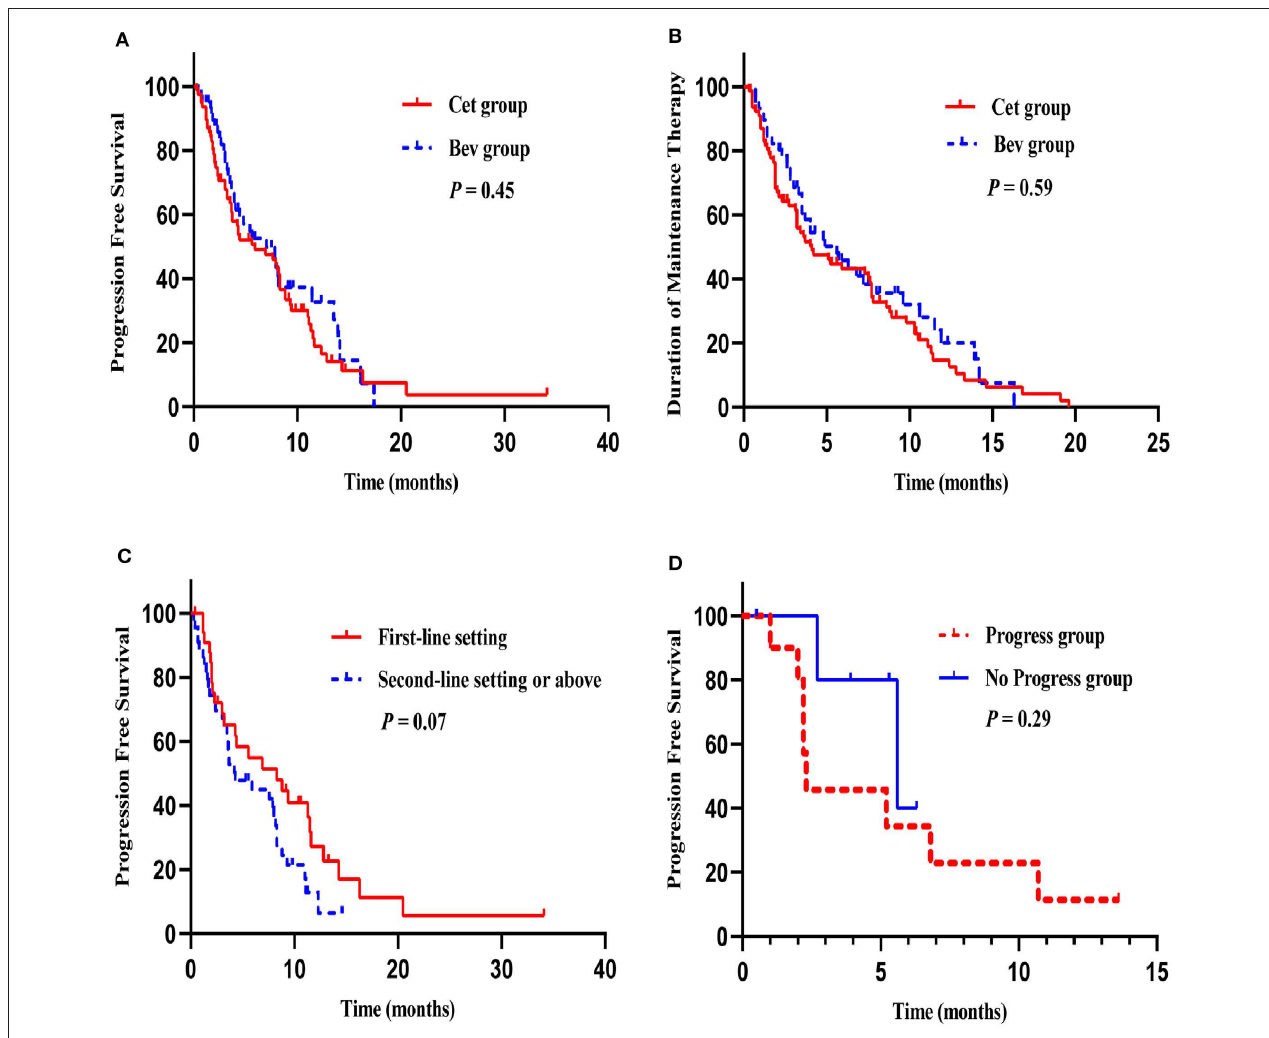
FIGURE 2 | Survival curves. PFS in the Cet group and Bev group (A) , The median duration of maintenance therapy in the Cet group and Bev group (B) , PFS of maintenance therapy after first-line induction chemotherapy and second-line chemotherapy or above in the Cet group (C) , PFS of maintenance therapy in progress group and no progress group after the reintroduction of the original plan (D)